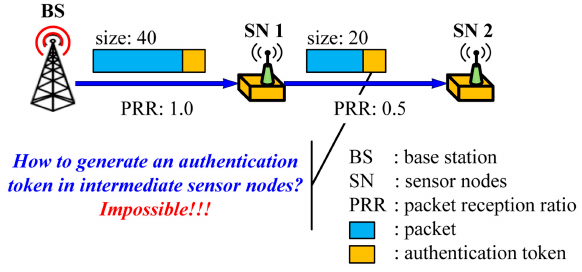
Figure 3. The problem of existing source authentication schemes in code dissemination supporting dynamic packet size.